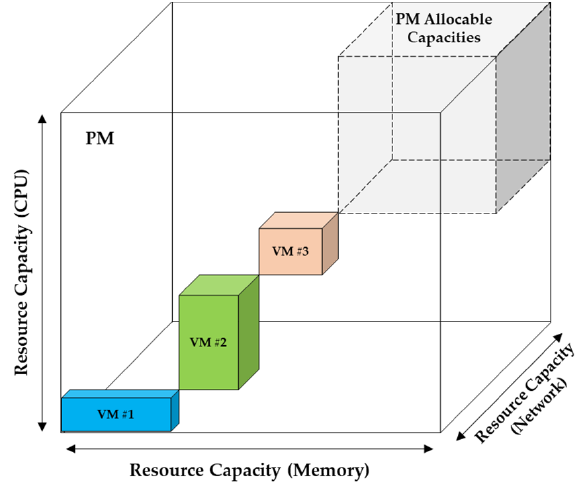
Figure 2. Multidimensional vector packing problem scheme.